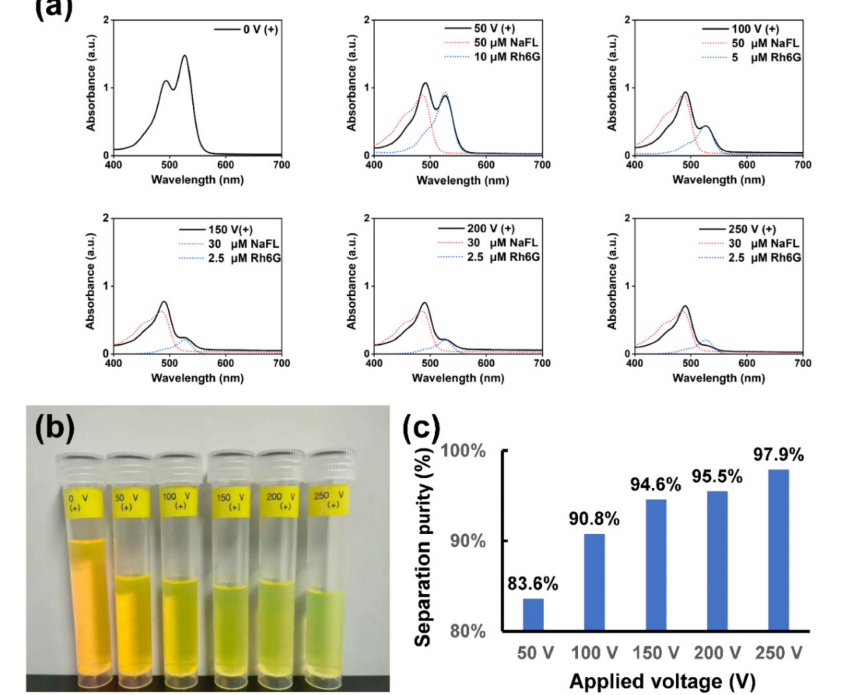
Figure 4. ( a ) Absorption spectra (solid curves) of the products collected from outlet 1 (near the positive electrode) with different applied voltages ranging from 0 V to 250 V. Blue and red dashed curves are absorption spectra of the Rh6G solution and the NaFL solution with different concentrations for reference, respectively. ( b ) Photo of the products collected from outlet1 (near the positive electrode) with different applied voltages. ( c ) Estimated separation purity versus applied